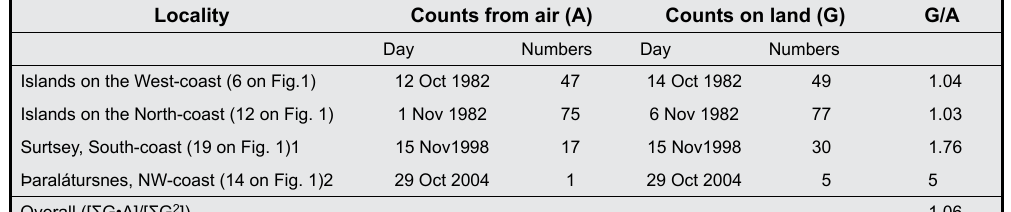
Table 1. Comparison of counts of grey seal ( Halichoerus grypus ) pups made on land (G) and from the air (A), on the same locality. These counts were used to produce correction factor ap- plied to aerial counts to account for missed pups in each region during aerial